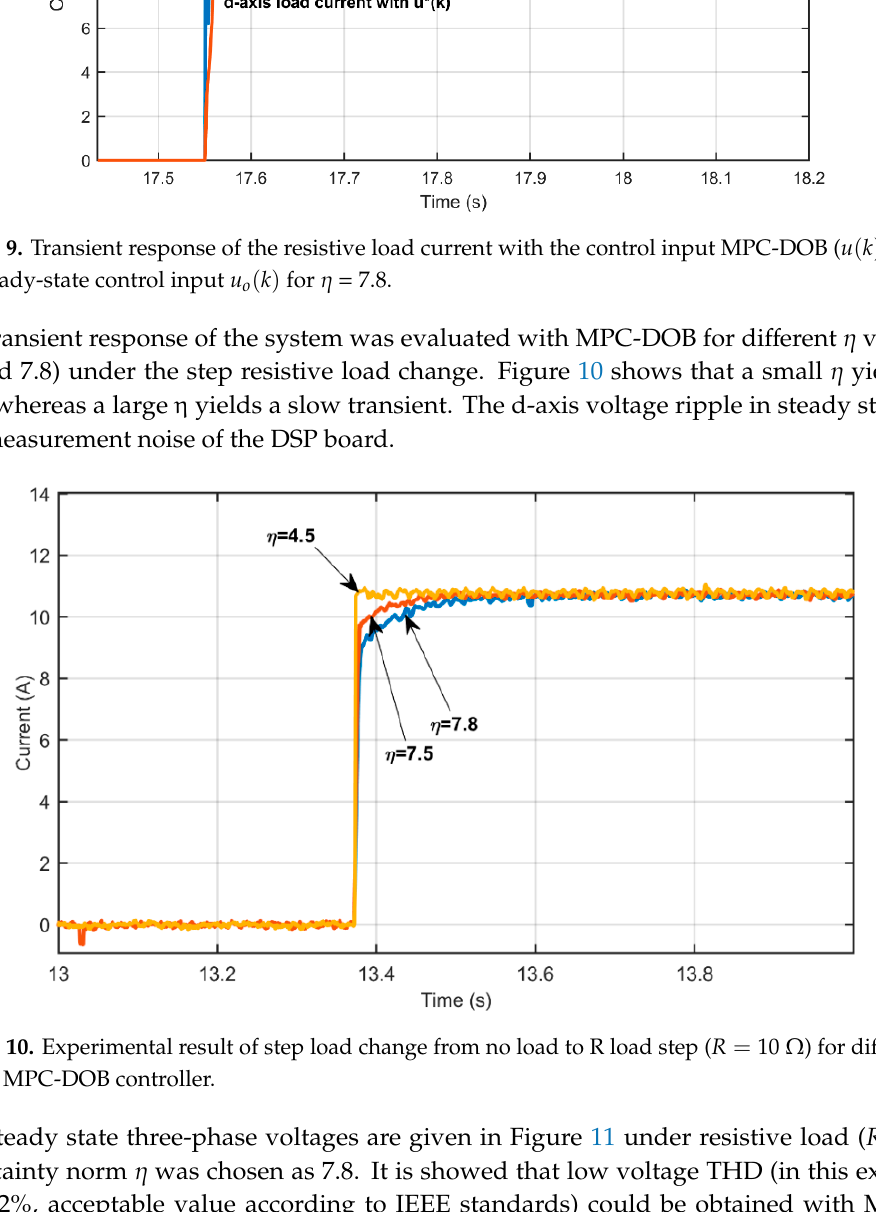
Figure 11. The steady state response of the three-phase output voltages with MPC-DOB under the resistive load ( η = 7.8, (cid:1844) = 10 Ω , (cid:1846)(cid:1834)(cid:1830) = 1.2% ).